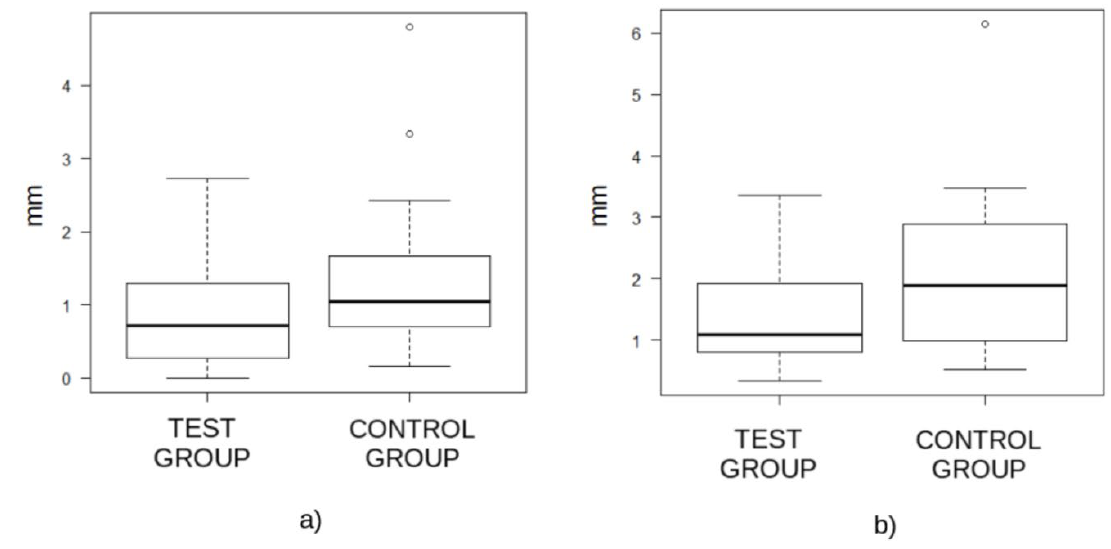
Figure 5. ( a ) Median and interquartile range of monthly apex speed in each group; ( b ) median and interquartile range of monthly cusp speed in each group.